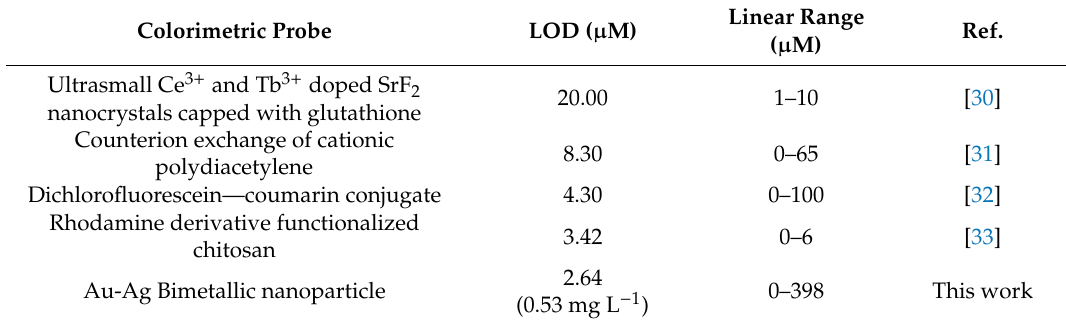
Table 1. Comparison of di ff erent methods for determination of mercury (II) .